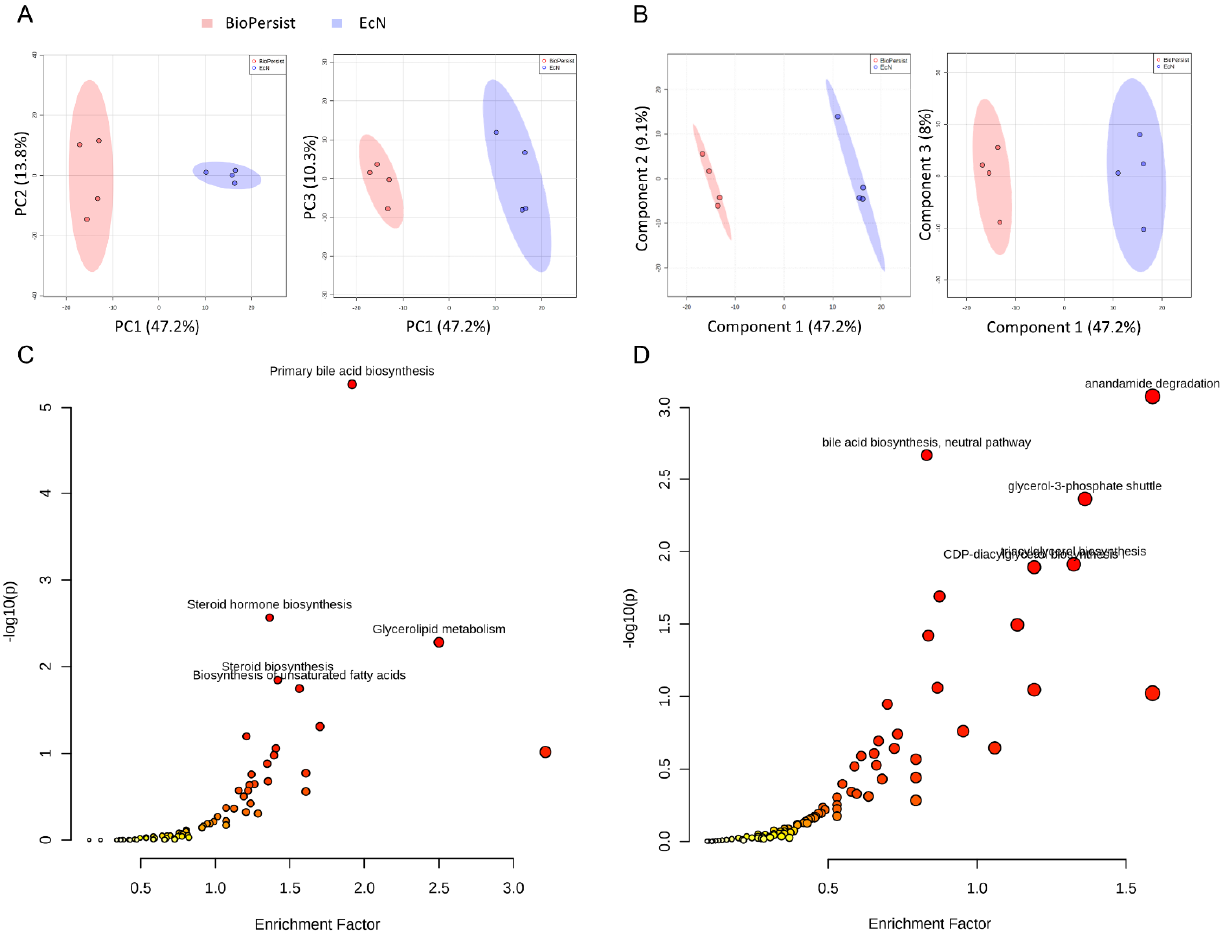
Figure 1. Signature pathways of mice treated with EcN and BioPersist. ( A ) PCA score plots with PC1 against PC2 and PC1 against PC3 for mice treated with EcN and BioPersist. ( B ) PLS-DA score plots with Component 1 against Component 2 and Component 1 against Component 3 for mice treated with EcN and BioPersist. ( C ) Significant pathways annotated with mouse KEGG and ( D ) BioCyc. n = 4 for each group. Table 2. Significant pathways hit by the mouse BioCyc database.